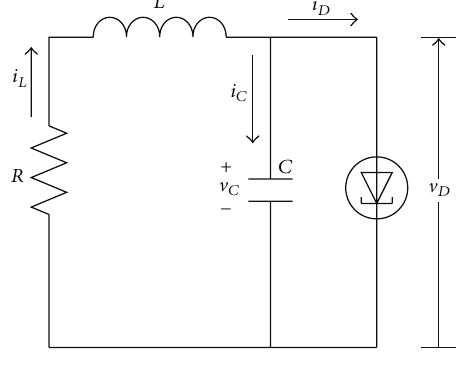
Figure 1: Tunnel diode circuit system.